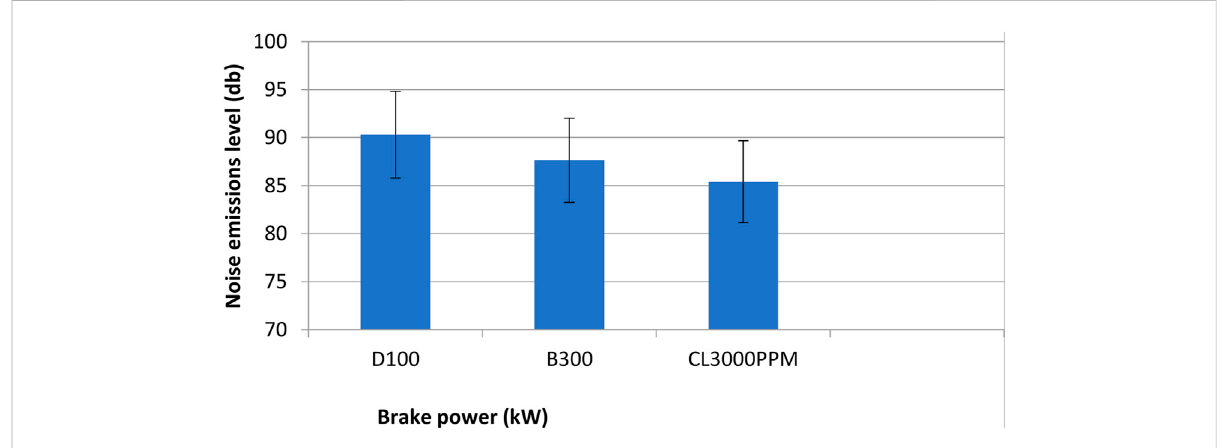
FIGURE 11 Average of the noise emission level of the error